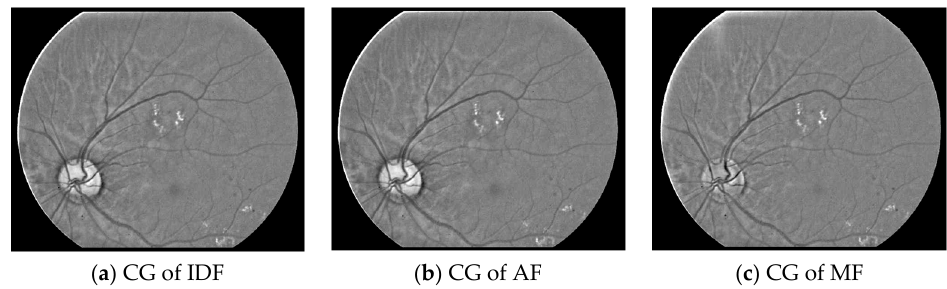
Figure 4. The contrast-adjusted green (CG) channels obtained from the three filters. The B, G and R channels of a fundus image can be diagnosed separately in greyscale.